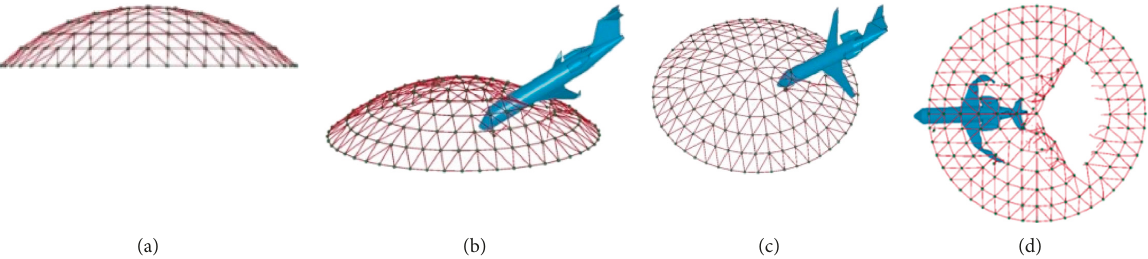
Figure 8: Deformations in the reticulated dome under oblique impact at different velocities. Main bars (a) before impact, (b) after 80m/s impact, (c) after 100m/s impact, and (d) after 120m/s impact.